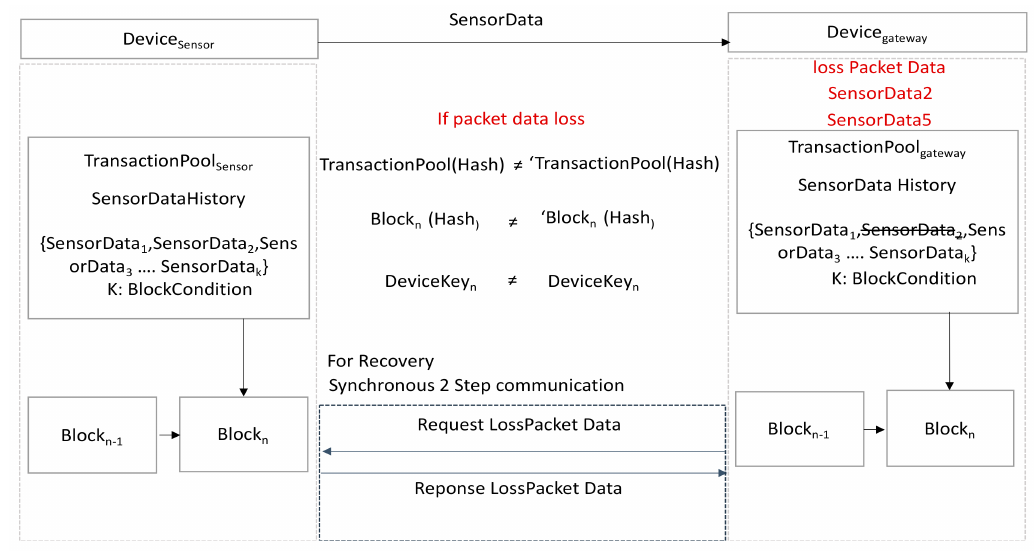
Figure 5. Dynamic encryption key mismatch due to packet